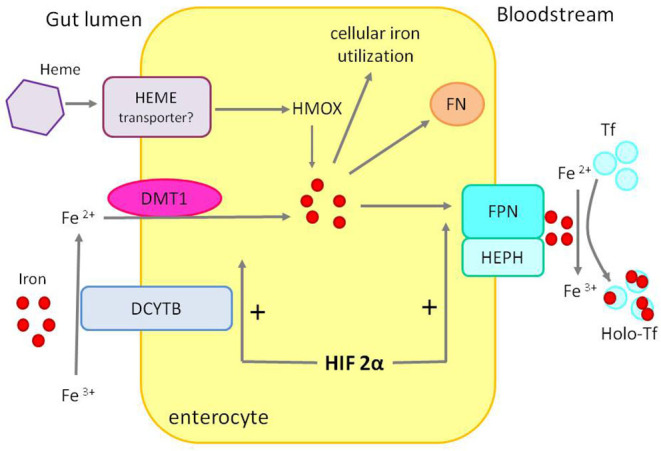
Duodenal iron absorption. The iron transporter DMT1 takes up ferrous iron, reduced from ferric iron by DCYTB, on the enterocyte's luminal. Iron can be used inside the cell, exported to circulation by FPN after ferrous iron is oxidized to ferric iron by HEPH or stored in FN. Heme, after entering the enterocyte through an unknown mechanism, is converted to iron by HMOX. HIF 2α stimulates the expression of DMT1 and FPN—apical and basolateral transporters. DCYTB, duodenal cytochrome B reductase; DTM1, divalent metal transporter 1; FPN, ferroportin; HEPH, hephaestin; HMOX, heme oxygenase; FN, ferritin; Tf, transferrin; Holo-Tf, holotransferrin.